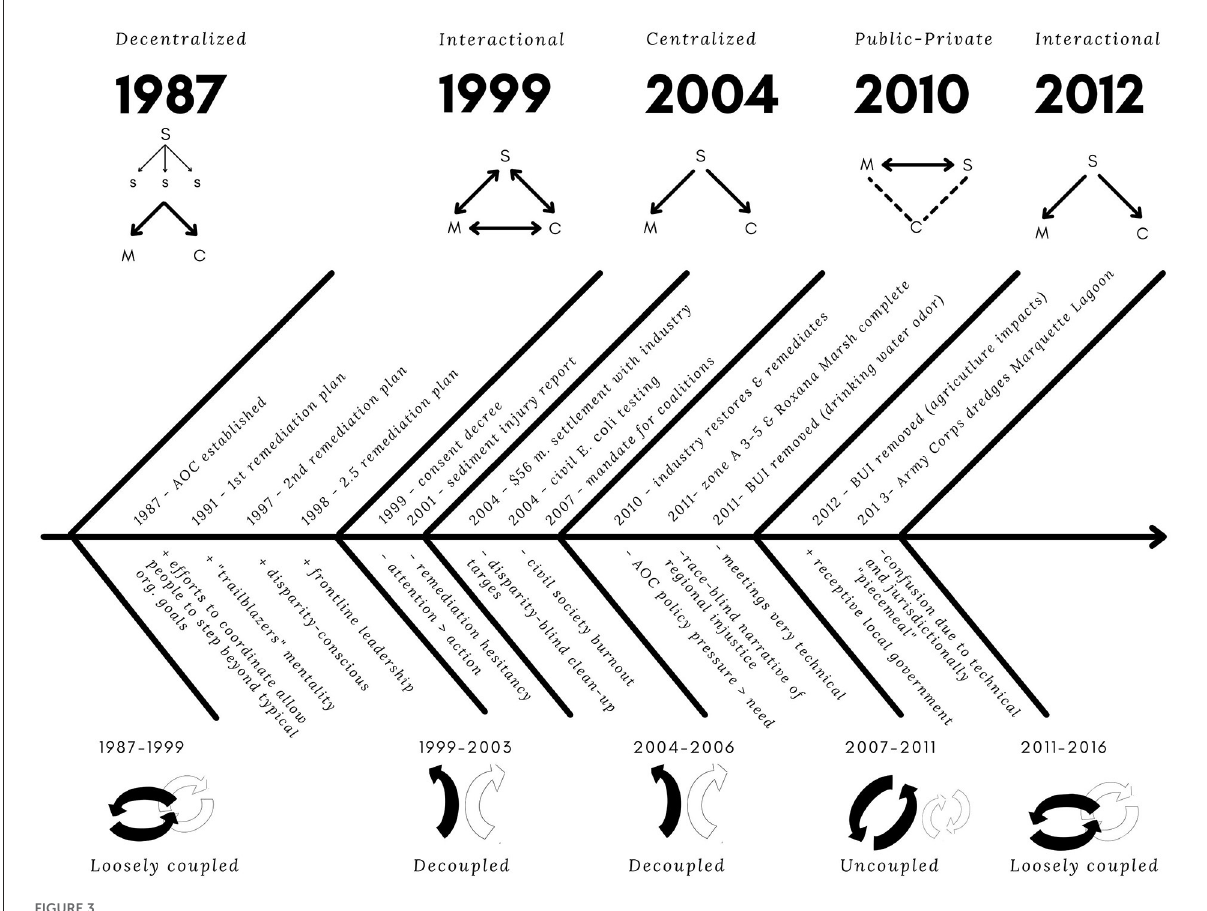
FIGURE3 Grand calumet area of concern EGM-EJ